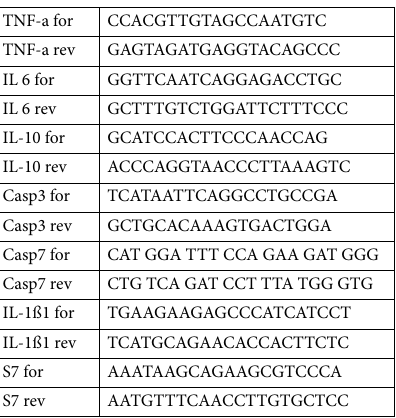
Table 1. Primers for mRNA detection. TNF tumor necrosis factor, IL interleukin, Casp Caspase, S7 ribosomal protein